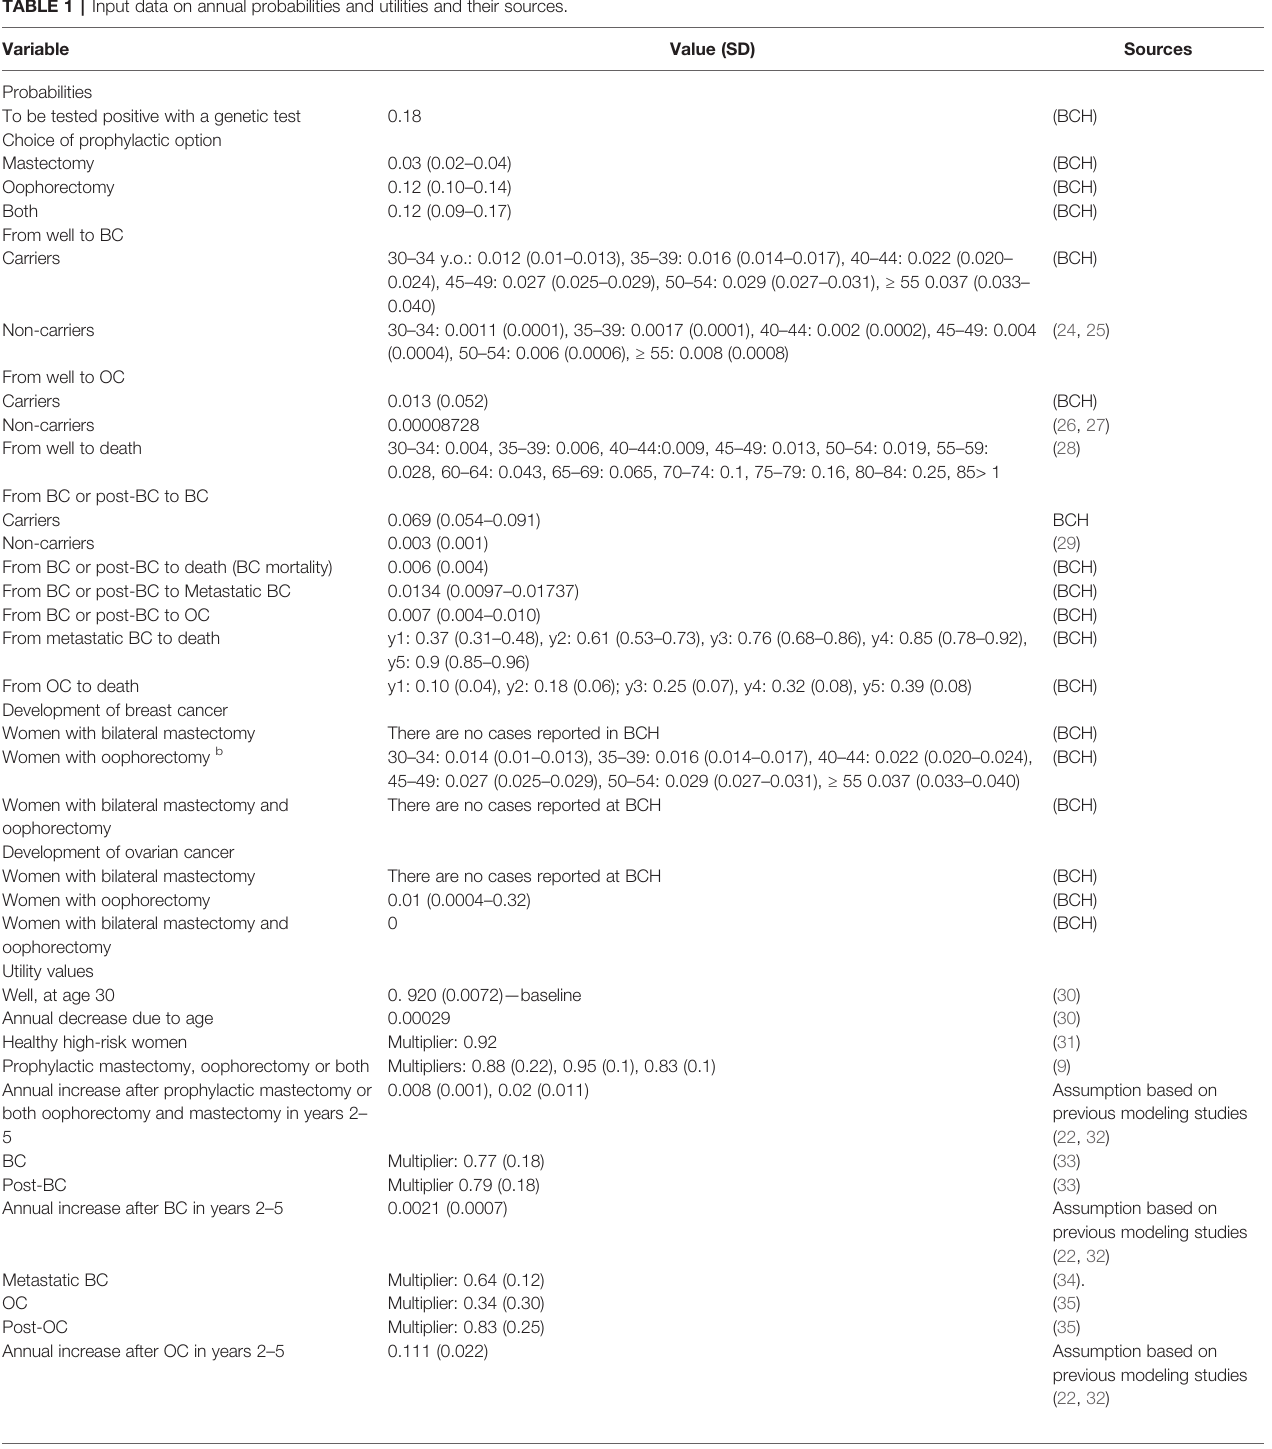
TABLE 1 | Input data on annual probabilities and utilities and their